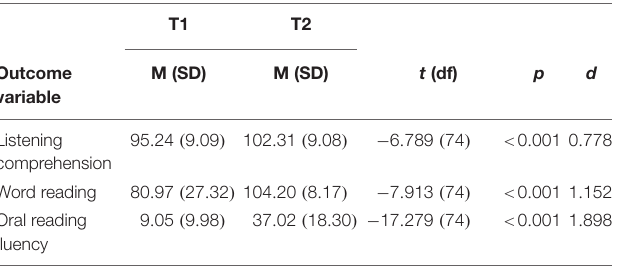
TABLE 1 | Differences in listening comprehension, word reading, and oral reading fluency between pre-test and post-test. T1